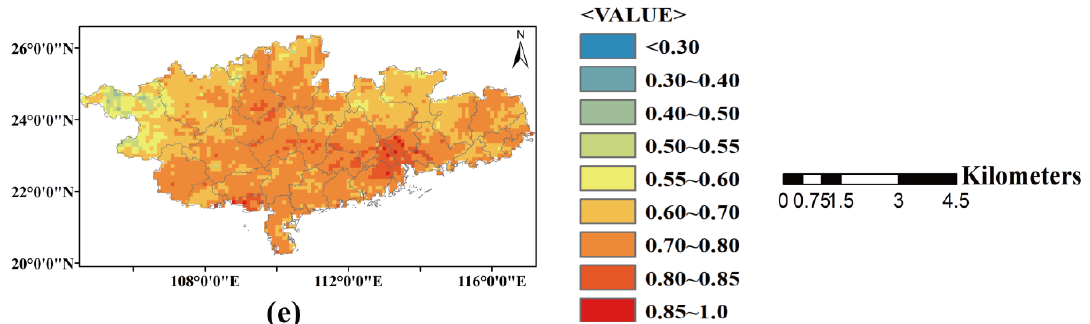
Figure 9. Spatial patterns in terms of probability of detection (POD) based on ( a ) PERSIANN-CCS, ( b ) ERA5-Land, ( c ) FY-4A, ( d ) GSMaP, and ( e ) IMERG against CMPA at hourly scale over southern China in summer 2019.